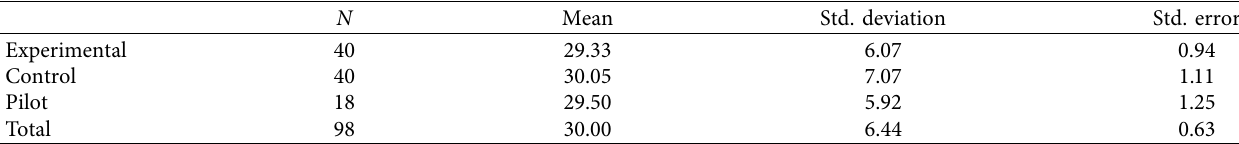
Table 1: Descriptive statistics in